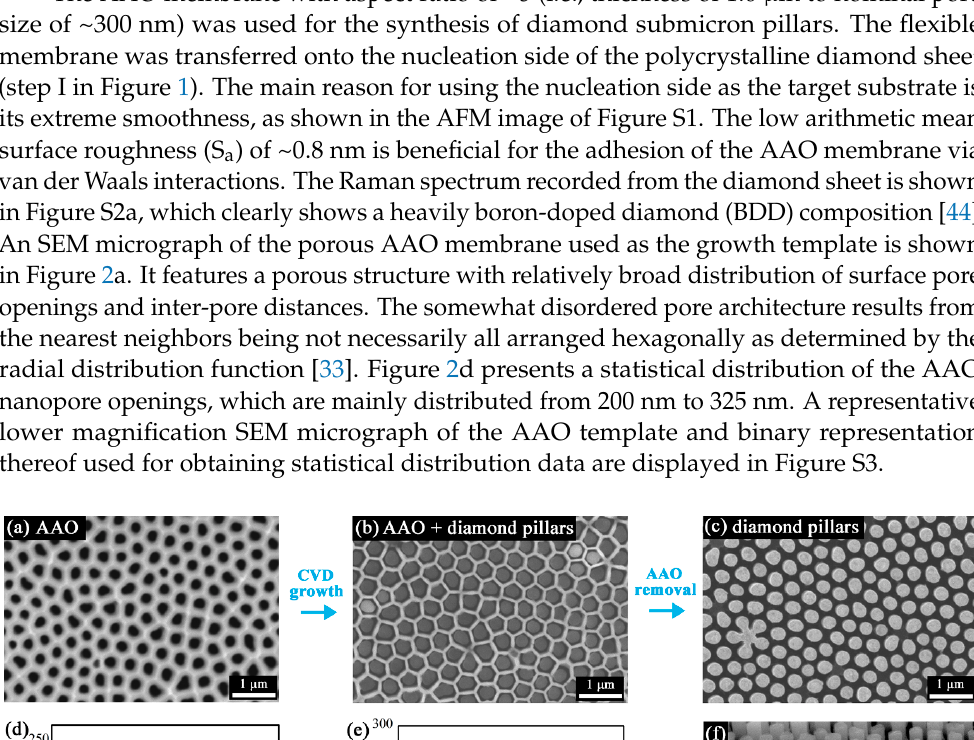
Figure 3. SEM images of diamond nanopillars at the boundary region: ( a ) top view and ( b ) tilted view. Regions I, II, and III indicate the distinct zones of templated growth of pillar array, transition zone, and plain growth of diamond, respectively. 3.2. Growth of Diamond Nanopillars with ~70 nm Diameter